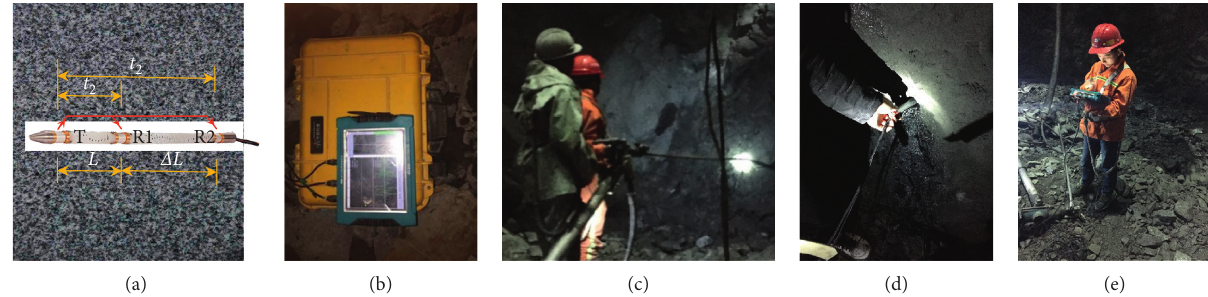
Figure 7: Testing process of ultrasonic tests: (a) test schematic diagram; (b) test equipment; (c) drilling test hole; (d) move the placement of the sensor; (e) data collection.